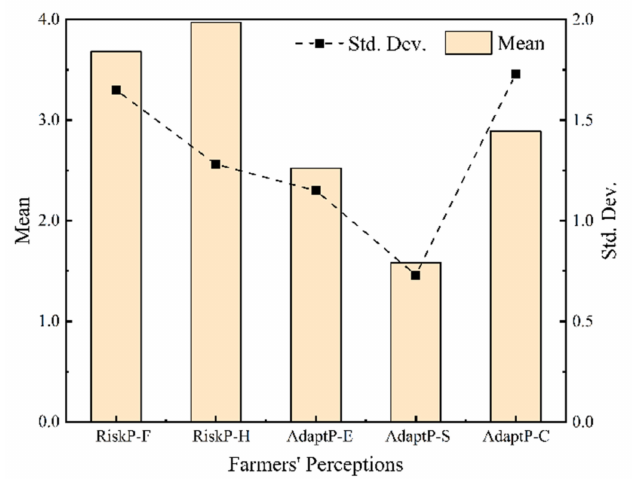
Figure 4. Levels of perceptions on HMP in cultivated land.